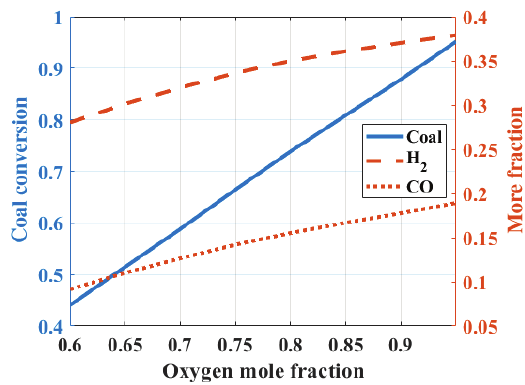
Fig. 8 – Pareto-optimal solution set after 20,000